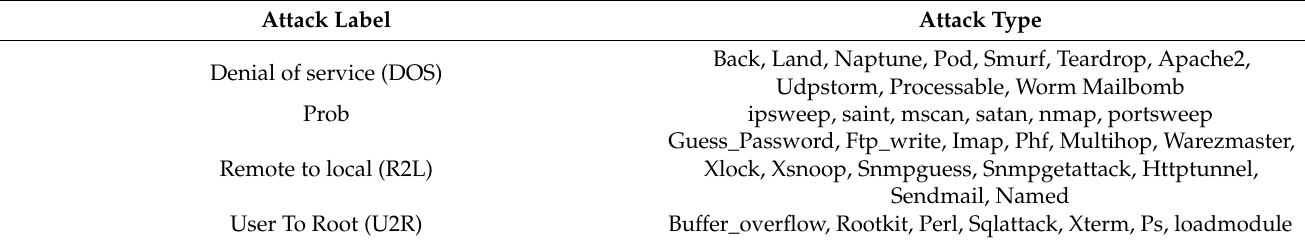
Table 2. Test set attack classification. Data from [23,24].